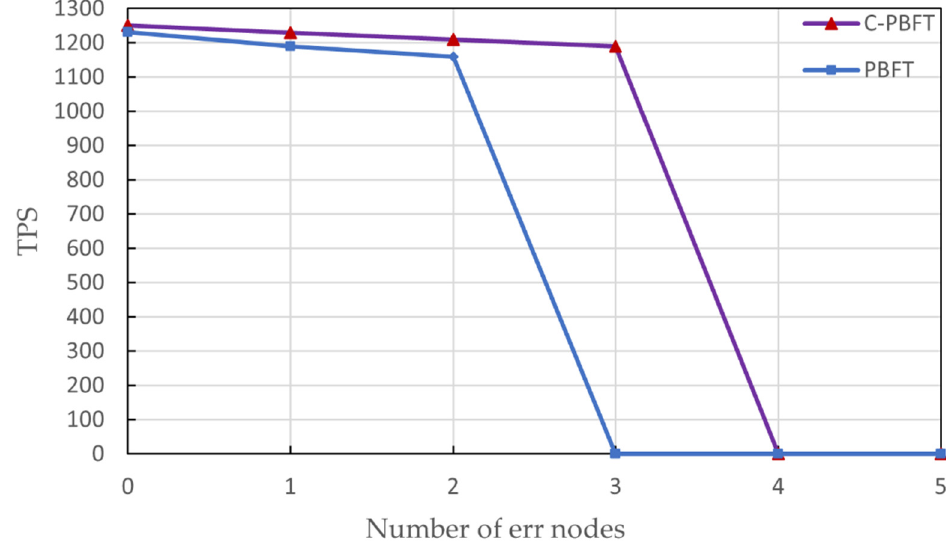
Figure 6. Relationship between error nodes and throughput.